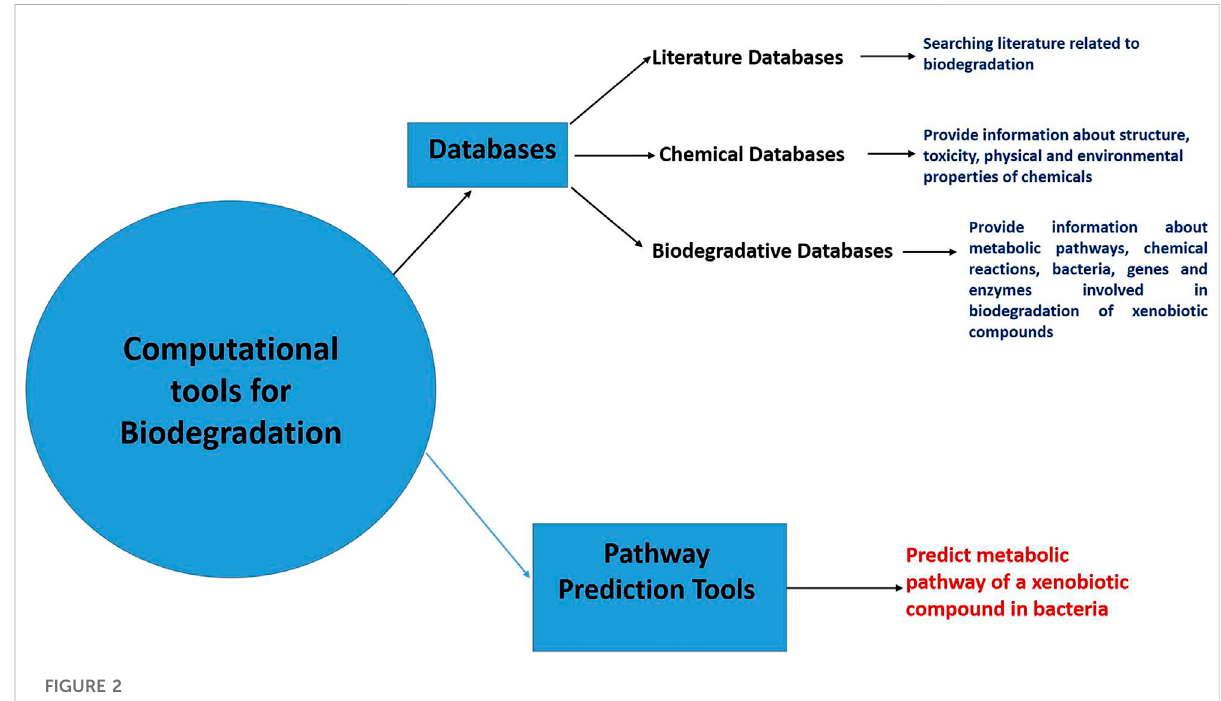
FIGURE 2 Role of various databases and pathways prediction systems in biodegradation